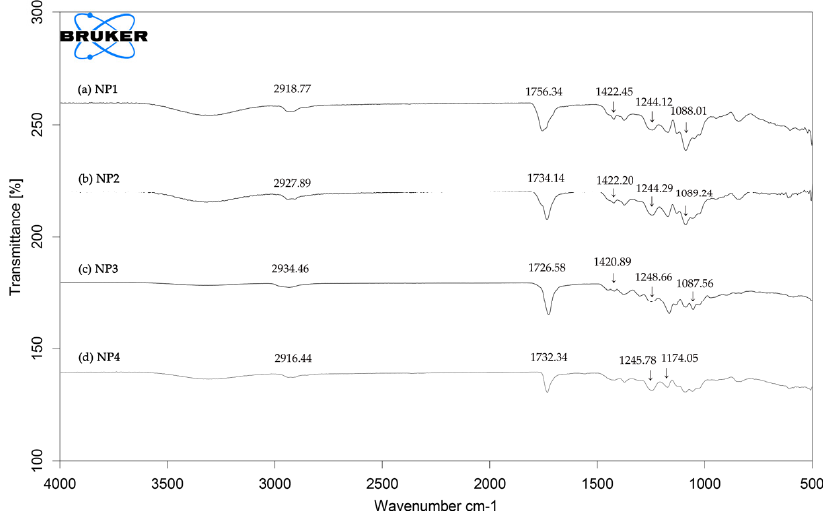
Figure 1. FT-IR spectra of NPs ( a ) NP1, ( b ) NP2, ( c ) NP3, ( d ) NP4. The major peaks are indicated for spectra of each of the NPs.